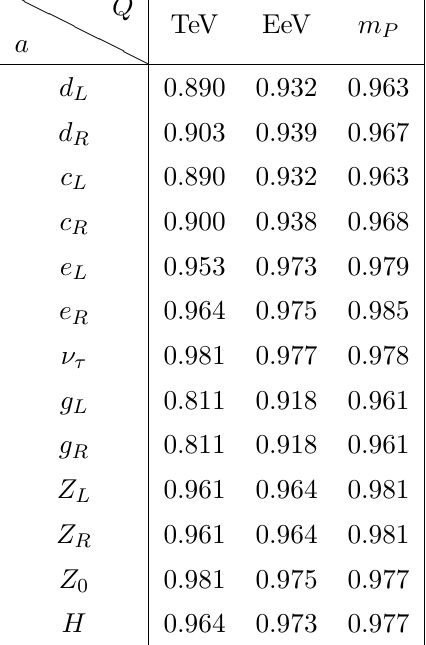
Table 3 . Momentum sums determined from eq. (F.1) for a representative subset of initial states and Q values. In all cases, disagreement from unity primarily results from our treatment of soft coherence, outlined in appendix